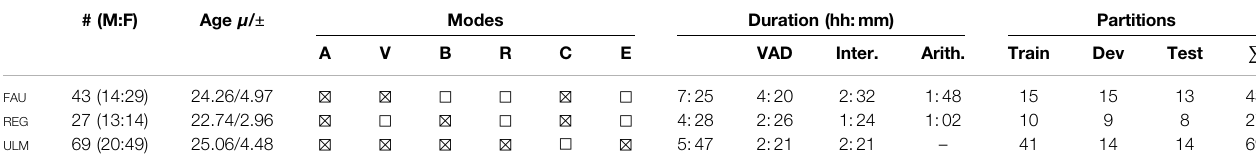
TABLE1| Anoverviewofeachofthethreecorpora( FAU )( REG )and( ULM )-TSSTusedwithinthiscontribution.Including,numberofsubjects(#),distributionofgender(M)ale:(F) emale, Ageinyears(mean/standarddeviation),continuoussignalsavailableforeach — (A)udio,(V)ideo, heartrateasbeatsper minute(B)PM,(R)espiration,(C)ortisoland (E)motion (arousal and valence) — as well as, the speaker independent partitions, train, (dev)elopment and test, and the duration of audio data, after voice activity detection (VAD) and for each TSST task, (Inter)view, and (Arith)methic. # (M:F) Age μ /